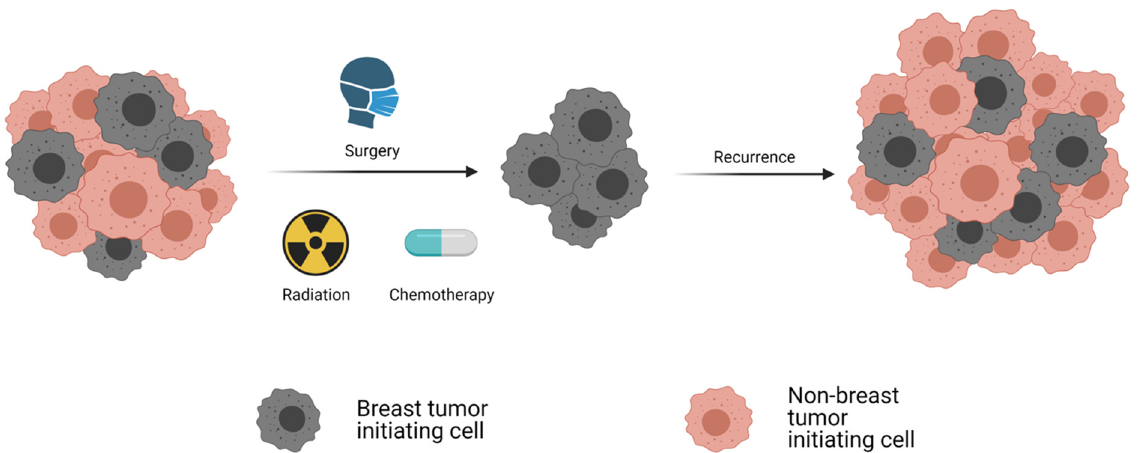
Figure 1. The breast cancer stem cell model for disease recurrence. Schematic conveying the clinical implications of therapy-resistant BTIC. Standard of care consisting of surgery and cytotoxic therapies principally eradicate non-BTIC. BTIC remain dormant until seeding local or distant disease recurrences.